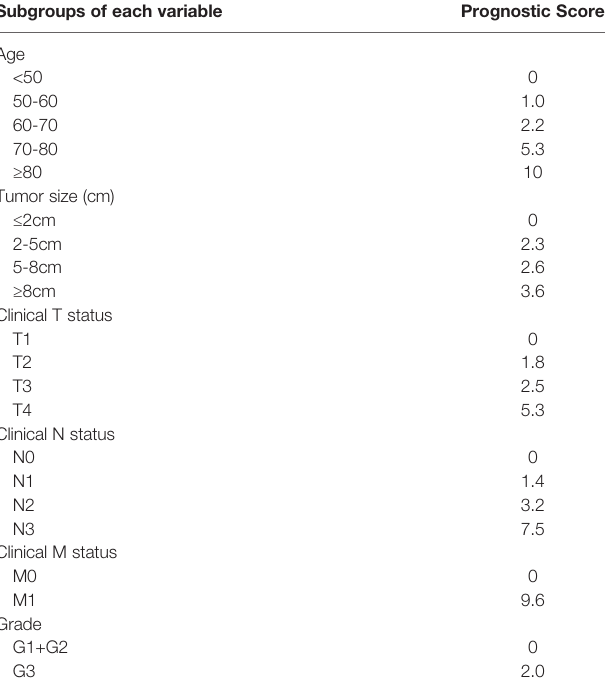
TABLE 3 | The prognostic scores of each subgroup within variable. Subgroups of each